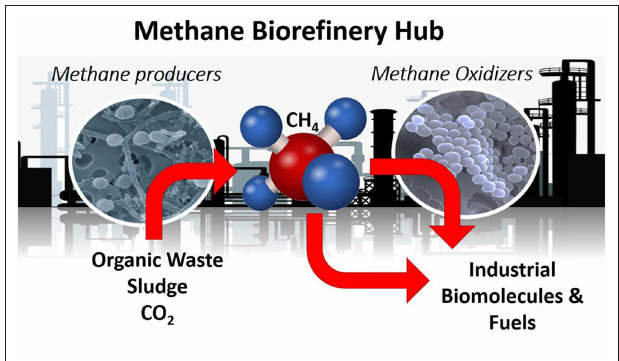
FIGURE 1 | Methane biorefinery for value chemical and biofuels. Microbial images (SEM) courtesy of Dr. Dennis Kunkel.